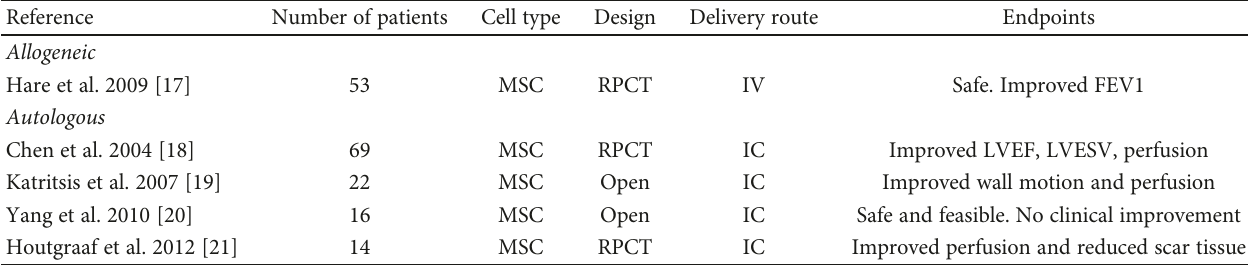
Table 3: Mesenchymal stromal cell trials in patients with acute myocardial